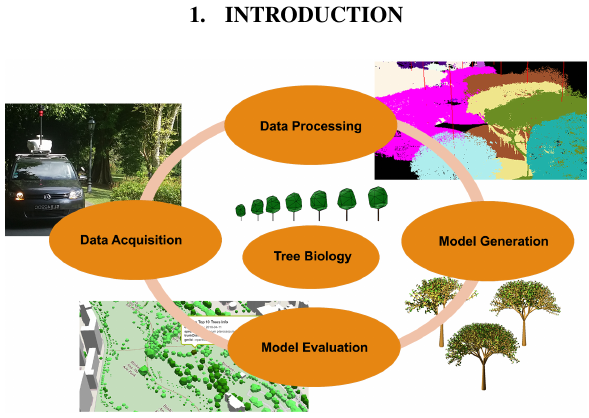
Figure 1. Workflow of interdependent components in the tree modeling